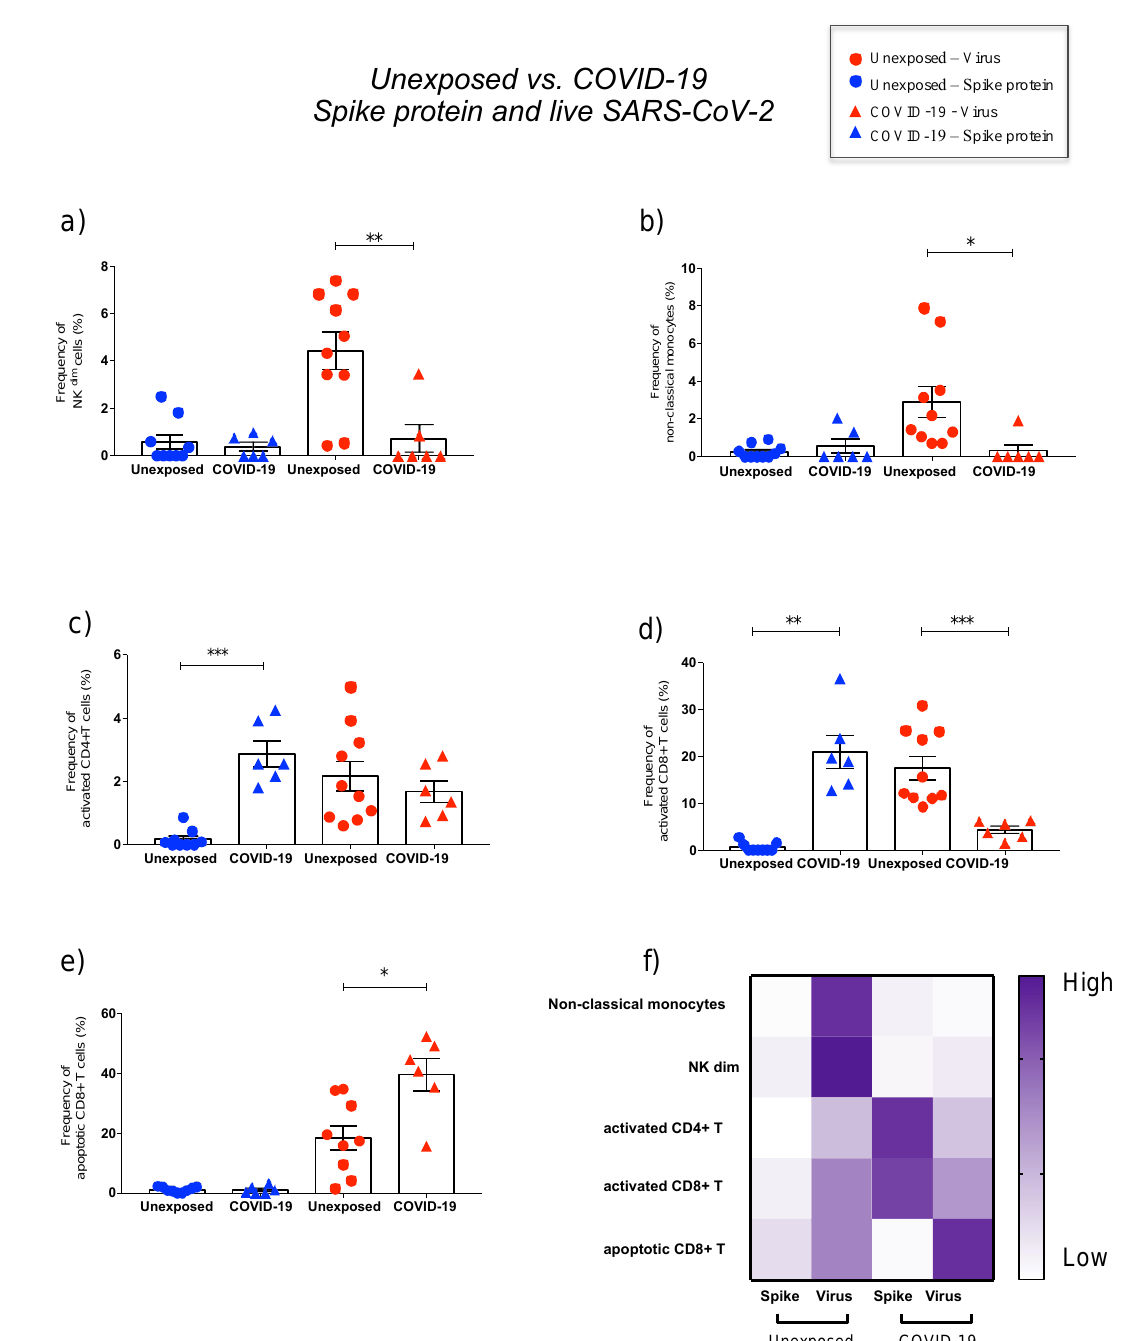
Figure 4. Major effects of spike protein and live SARS-CoV-2 on PBMC phenotypes comparing unexposed and COVID-19 groups. Percentage of natural killer cytotoxic subset (NK dim , CD3 − CD56 low CD16 high ) ( a ) and nonclassical monocytes (CD3 − CD14 − CD16 + ) ( b ) in unexposed (circles) and COVID-19 (triangles) after spike protein (blue) and in vitro virus exposure (red). Percentage of activated (CD69 + HLA − DR + ) CD4 + ( c ) and CD8 + T lymphocytes ( d ), as well as apoptotic (CD95 + ) CD8 + T lymphocytes ( e ) after antigen stimulation (spike protein and virus). Heat map of phenotypes percentages affected by spike protein and live virus stimulation on unexposed and COVID-19 ( f ). The final value percentage represented by y axis is the percentage of cells activated by SARS-CoV-2 antigens subtracted from unstimulated cells (% of cells stimulated with spike protein or virus minus % of the cells from mock condition). Symbols legend represents each sample collected from each volunteer. The data are representative of 2–5 different experiments. * p < 0.05, ** p < 0.01, and *** p <